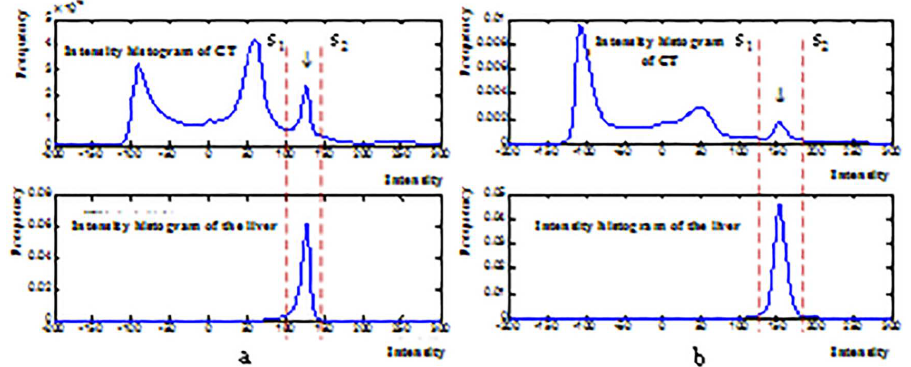
Fig 2. Gray value distributions of two images and the livers. (a) and (b) Distribution of two different